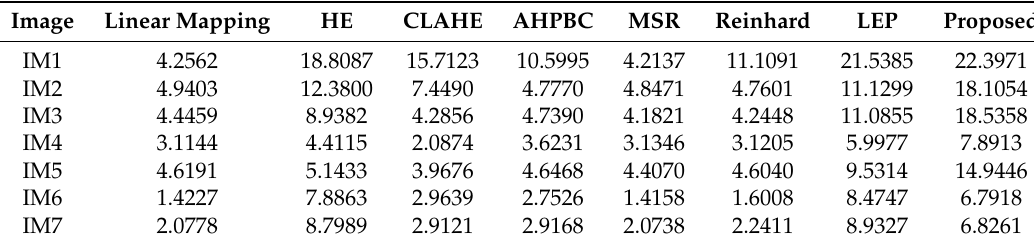
Table 2. The Tenengrad’s value of the images.